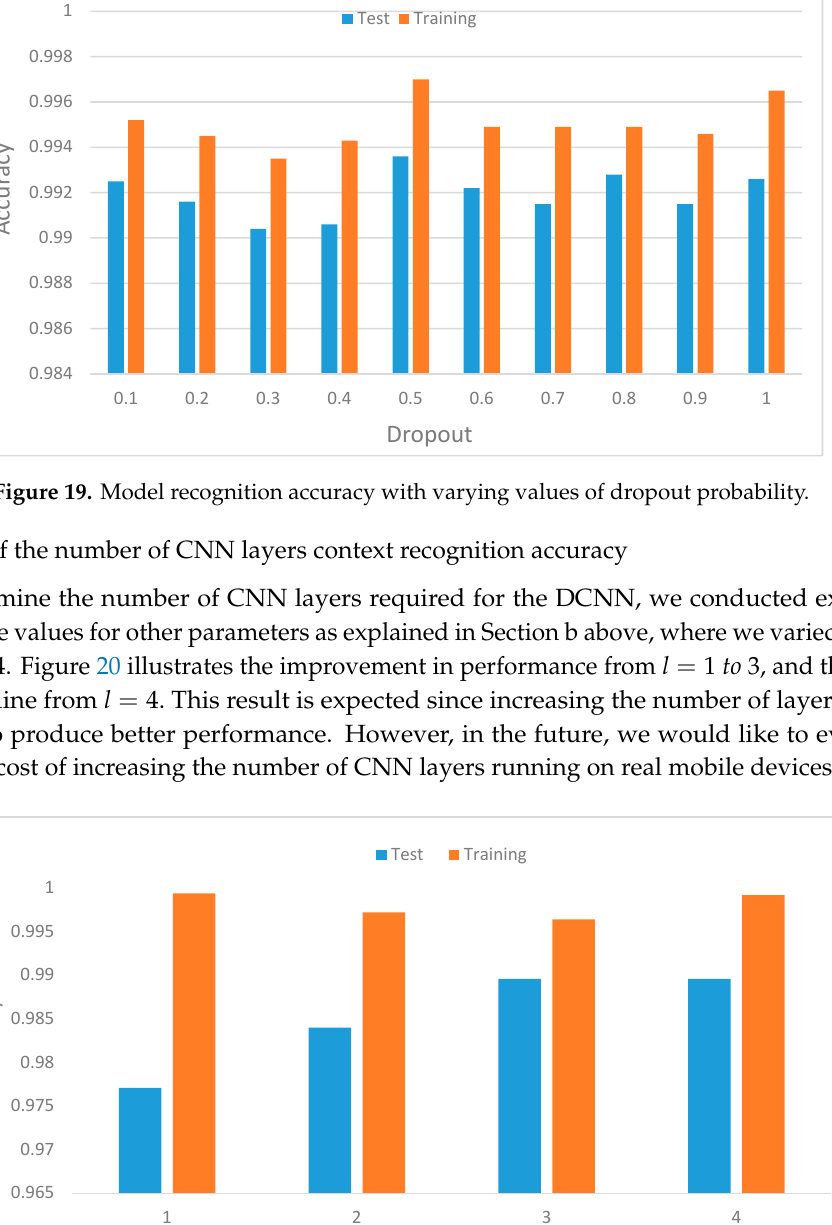
Figure 21. Model recognition accuracy with increasing number of nodes in the fully connected layer.